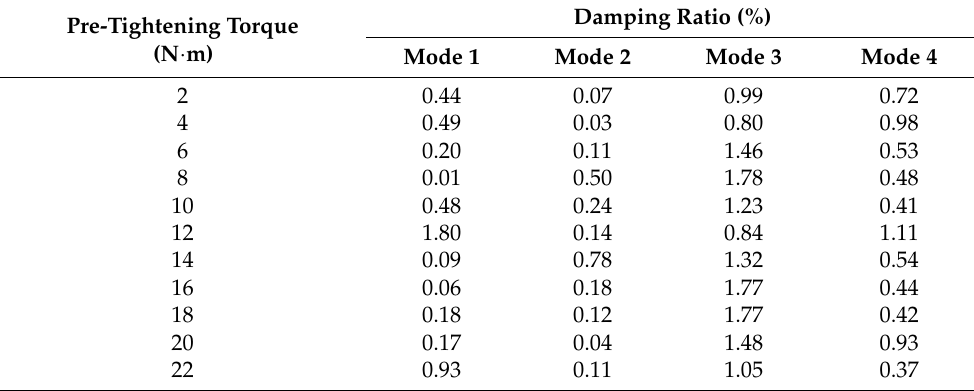
Figure 7. The relationship between the experimental frequency and the pre ‐ tightening torque. The damping ratio of the bolted connection structure is related to many factors, such as material performance, medium condition, surface roughness, processing method, pre ‐ tightening force state and loading frequency, the influence of which is mostly reflected in nonlinear relations. In addition, the measurement errors will also have an impact on the damping ratio. When measuring the frequency response functions, the measured result of the damping ratio is larger than the actual result due to the effect of accelerometer weighting functions. The first four order damping ratios under different pre ‐ tightening forces were obtained, and are all shown in Table 5. Furthermore, the relationship between the experimental damping ratio and the pre ‐ tightening torque was obtained as is shown Table 5. Experimental damping ratio under different pre-tightening in Figure 8.